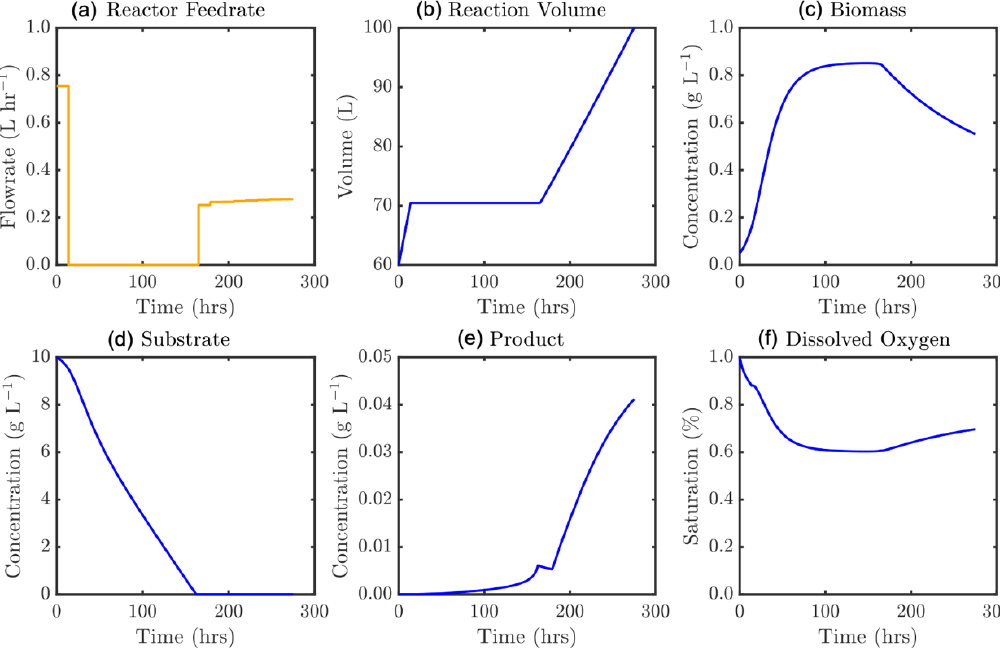
Figure 14. Optimal feedrate profile ( a ) and corresponding model states, ε = 275 h: ( b ) culture volume, and concentrations of ( c ) biomass, ( d ) substrate, ( e ) product, and ( f ) dissolved oxygen.